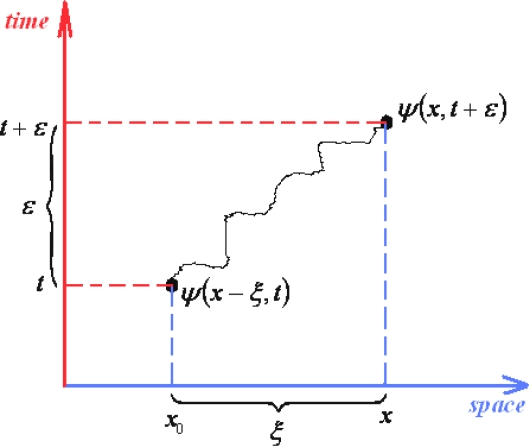
Depiction of the space-time elementary retarded path connecting two events characterized by their dynamic wave-functions.